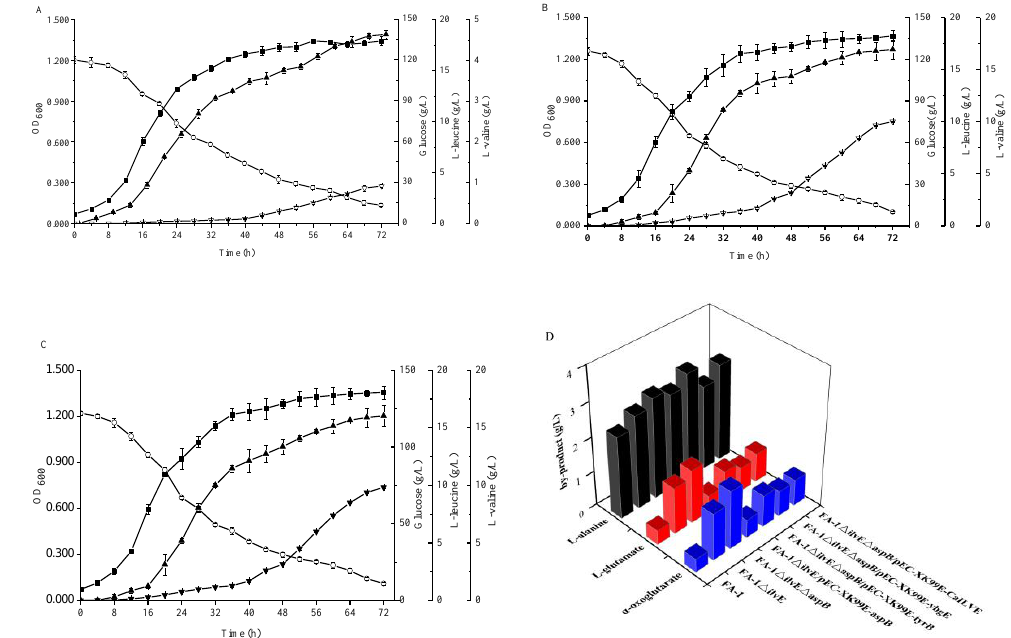
Figure 5. Comparison of the different strains during cultivation in shake-flasks with fermentation medium. ( A ) C. glutamicum FA-1 △ ilvE △ aspB /pEC-XK99E- tyrB , ( B ) C. glutamicum FA-1 △ ilvE △ aspB /pEC-XK99E- ybgE , ( C ) C. glutamicum FA-1 △ ilvE △ aspB /pEC-XK99E- CaIlvE , ( D ) by-products. Solid squares: OD 600 , Hollow circles: Glucose, Solid triangles: L -leucine, Hollow triangles: L -valine. The data represent mean values and standard deviations obtained from three independent cultivations. Table 2. Comparisons of shake flask culture parameters of BCAAs production by different strains. Strain L -Leucine All data represent values of three determinations of three independent experiments with ±SD.